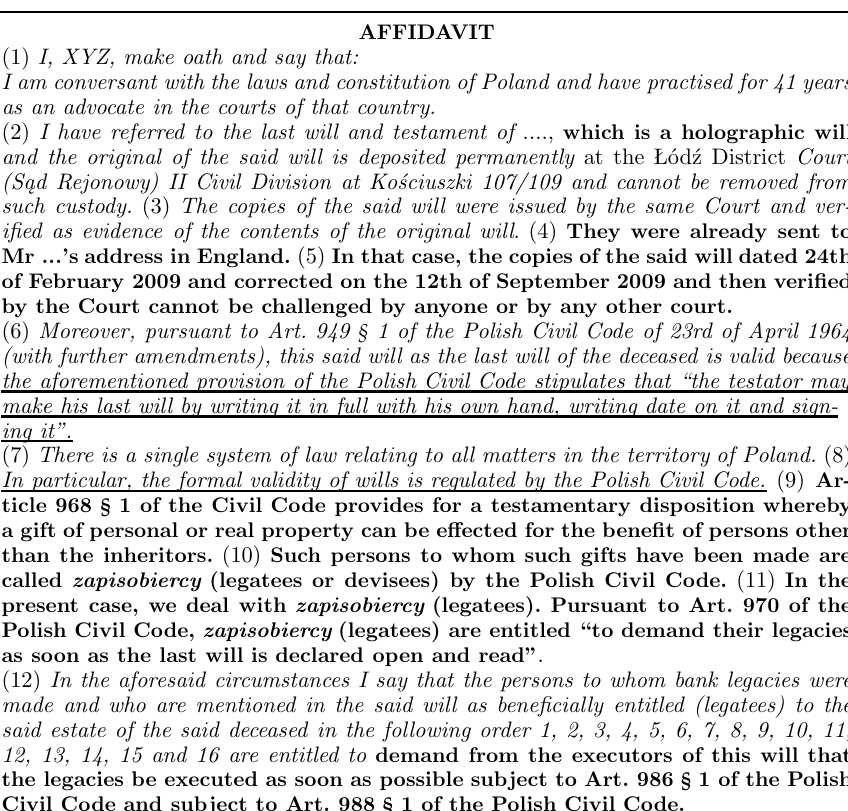
The affidavit drafted in Polish and then back-translated into